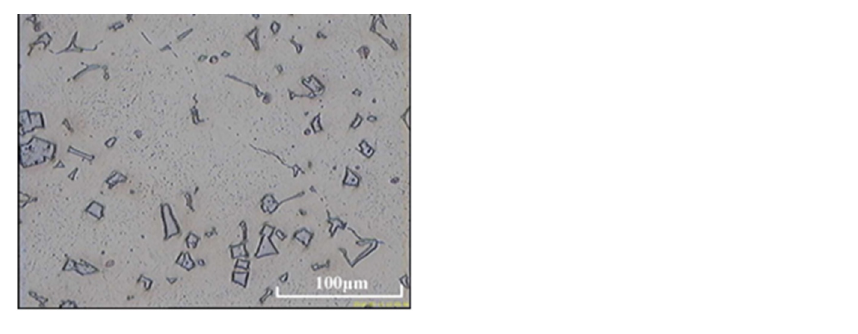
Figure 6. Sample microstructure of alloy with the addition of 2.0% Ti after solution heat treatment; austenitic matrix with primary titanium carbides evenly distributed in this matrix; Nital etching, [7].